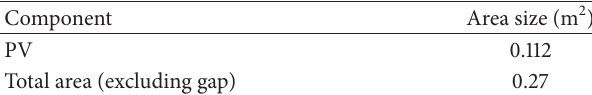
Table 1: Area size of the SPV/T.